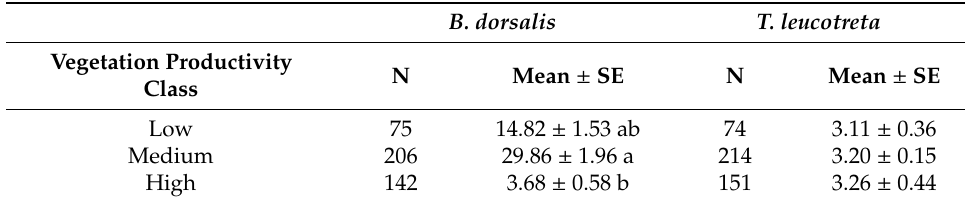
Table 1. Mean daily capture and standard error ( ± SE) of Bactrocera dorsalis , Thaumatotibia leucotreta across landscape vegetation productivity